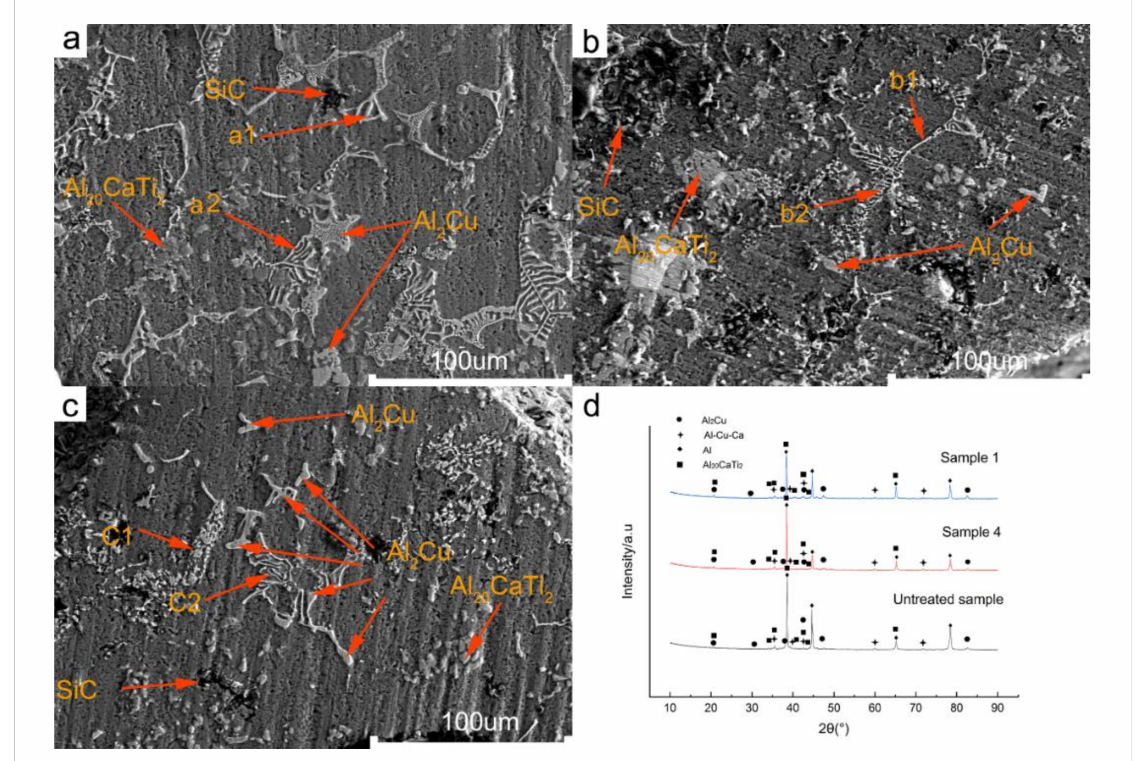
Figure 2. SEM (scanning electron microscopy) of cross-section at different temperature inter- vals ( a ) untreated sample, ( b ) sample 4 aged with low temperature, ( c ) sample 1 aged with high- temperature aging sample 1. ( d ) XRD of aging samples and untreated